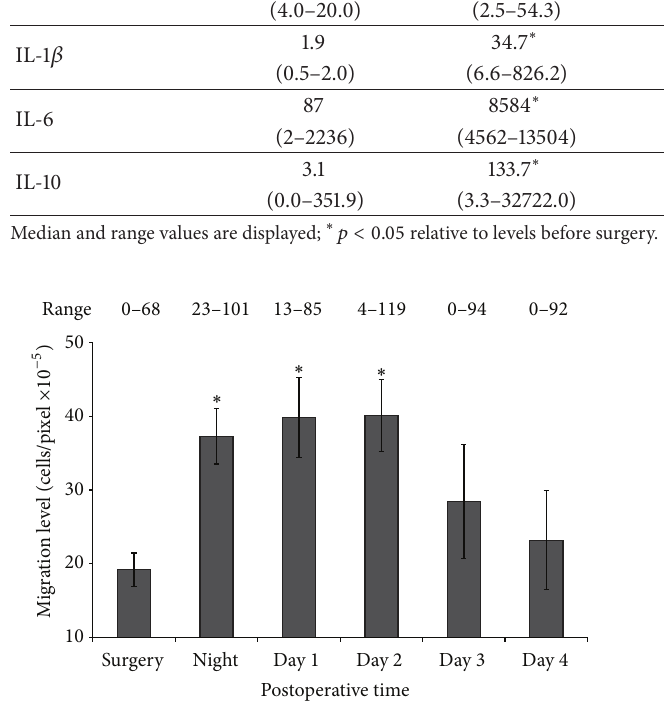
Figure 2: The effect of postoperative peritoneal fluids from one individual patient on the migration capacity of colon cancer cells SW480 in vitro . The correlated microscopic images are shown above the